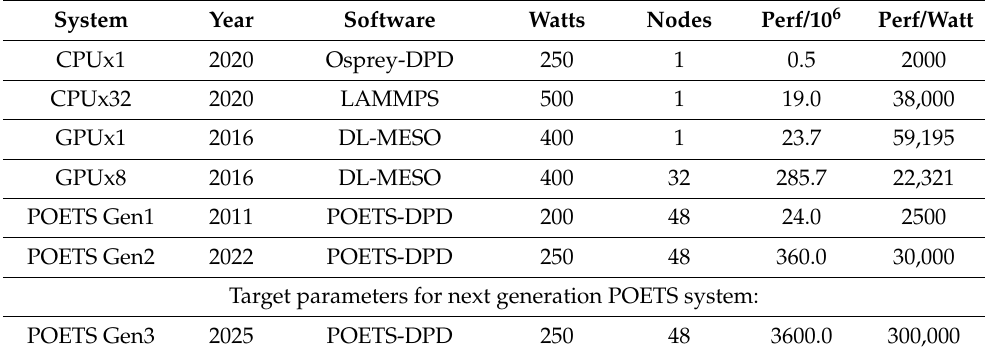
Table 2. Indicative performance of distinct compute platforms. Year: year hardware platform was intro- duced; Watts: power consumption of one node under load; Nodes: # compute nodes; Perf: performance in millions of bead-steps per second; Perf/Watt: performance per watt of electricity consumed. System Year Software Watts Nodes Perf/10 6 Perf/Watt CPUx1 2020 Osprey-DPD 250 1 0.5 2000 CPUx32 LAMMPS